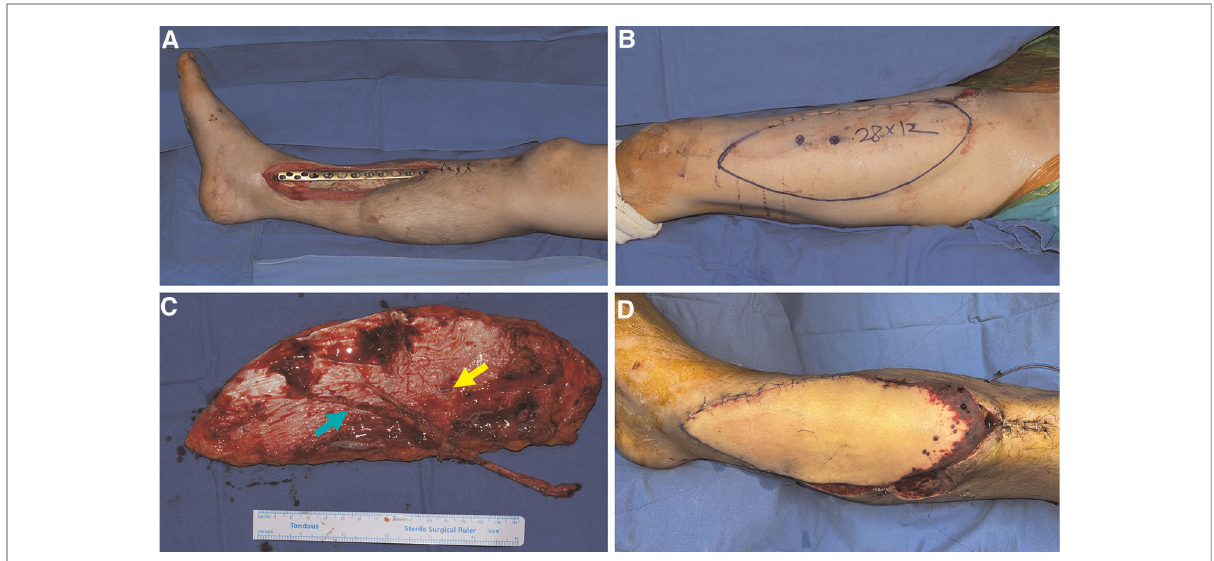
FIGURE 1 A case with partial necrosis of the transferred wide ALTP fl ap. ( A ) After radical debridement of necrotic bone and soft tissue, temporary bony fi xation using a metal plate and antibiotics-loaded bone cement was performed on a 48-year-old male patient who sustained a traf fi c accident. ( B ) A wide ALTP fl ap (28×12 cm 2 ) was harvested. ( C ) Although the fl ap was supplied by perforators from both TB-LCFA and DB-LCFA simultaneously, the fl ap was harvested, including only perforators from DB-LCFA after sacri fi cing a perforator from TB-LCFA (yellow arrow indicates a perforator from TB- LCFA; green arrow indicates DB-LCFA). ( D ) Venous congestion occurred 8 h after the surgery, leading to partial necrosis even after continuous medicinal leech therapy. ALTP, anterolateral thigh perforator; TB-LCFA, transverse branch of lateral circum fl ex femoral artery; DB-LCFA, descending branch of lateral circum fl ex femoral